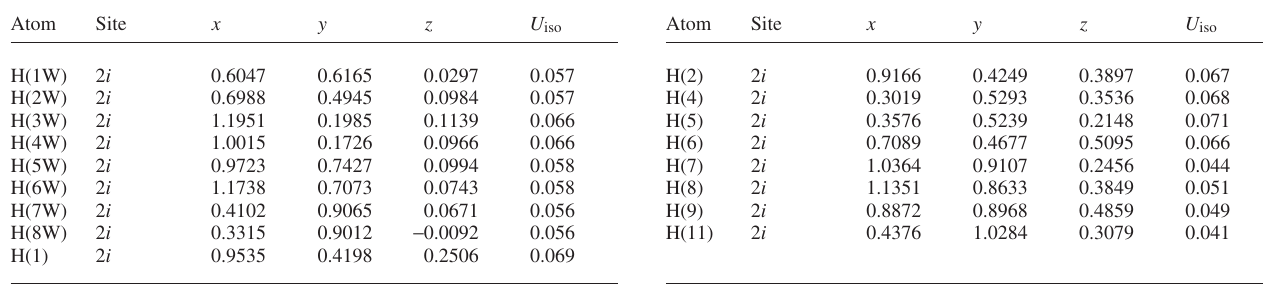
Table 3. Atomic coordinates and displacement parameters (in Å 2 ) .